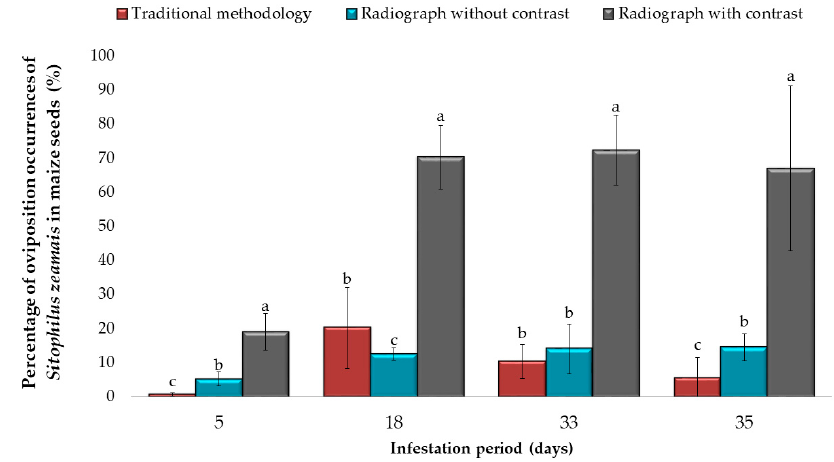
Figure 1. Detected oviposition occurrences of Sitophilus zeamais in maize seeds at 5, 18, 33 and 35 days after infestation by traditional method, radiograph without contrast and radiograph with contrast. The bar graph shows the means and the error bars show the ± standard deviations (SD) in each period of infestation (Tukey-Kramer Test, p < 0.05).